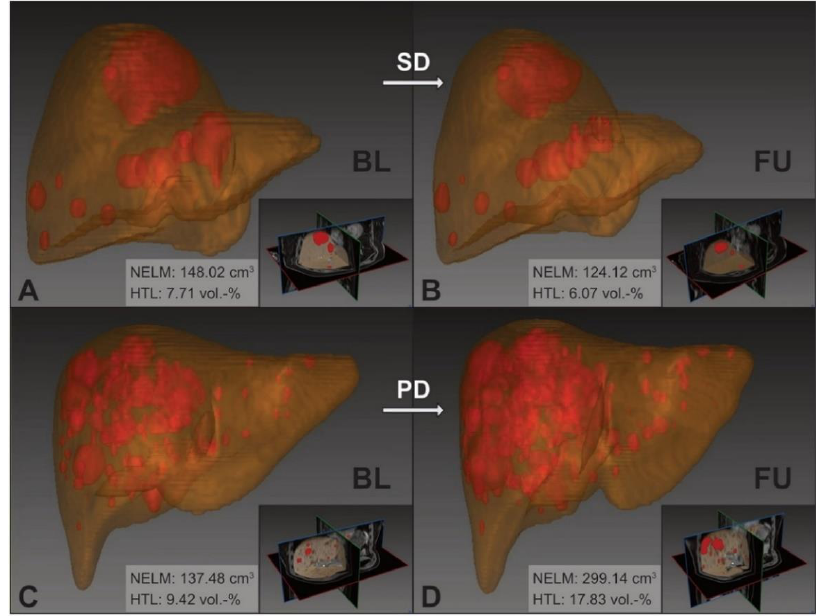
Figure 2. nnU-Net 3D segmentation of NELM and livers in the MCC cohort. Upper row: example images of therapy success (patient ID: 11) with stable disease between baseline ( A ) and follow-up ( B ); ∆ − 16.14% and ∆ − 21.23%. Lower row: example images of therapy failure (patient ID: 08) with progressive disease between baseline ( C ) and follow-up ( D ); ∆ rel NELM: +117.58% Table 2. Summary of the model’s segmentation results for the MCC cohort and their absolute and relative changes be- tween baseline and follow-up MRI examinations.